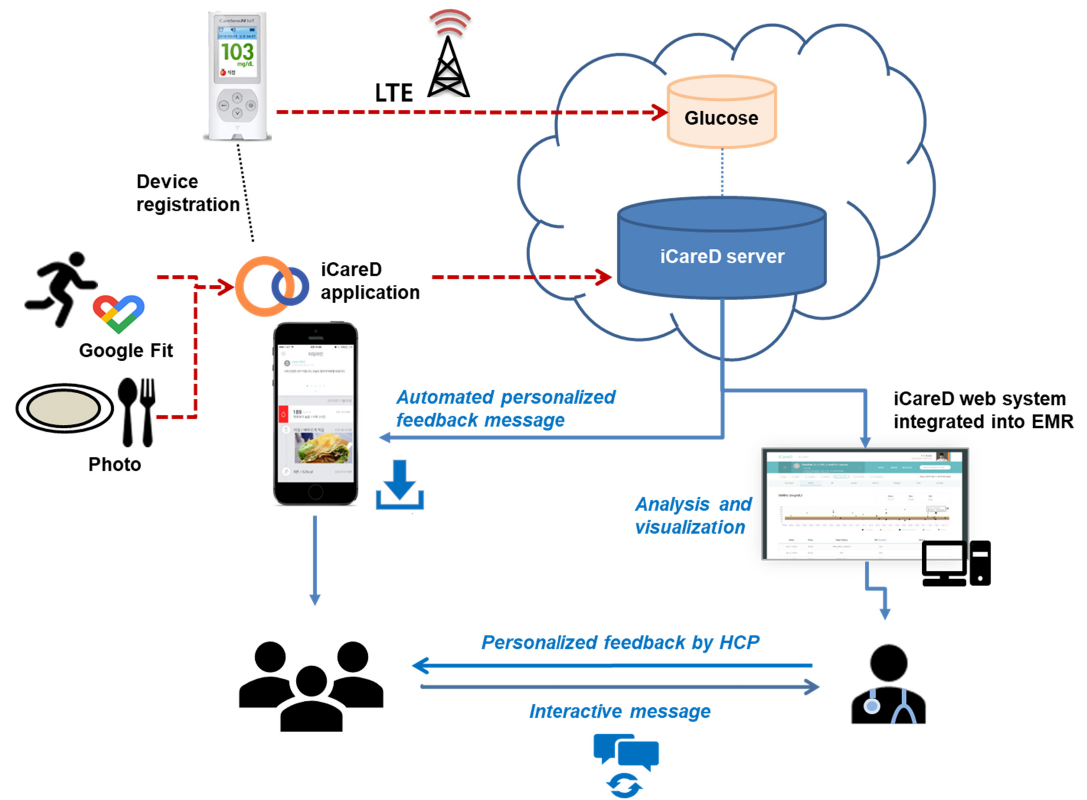
Figure 1. Technical architecture of the health coaching system supported by remote patient monitoring. EMR: electronic medical record; HCP: healthcare professional; LTE: long-term evolution. Broken bars represent raw data. Red and blue mean input and output, respectively.